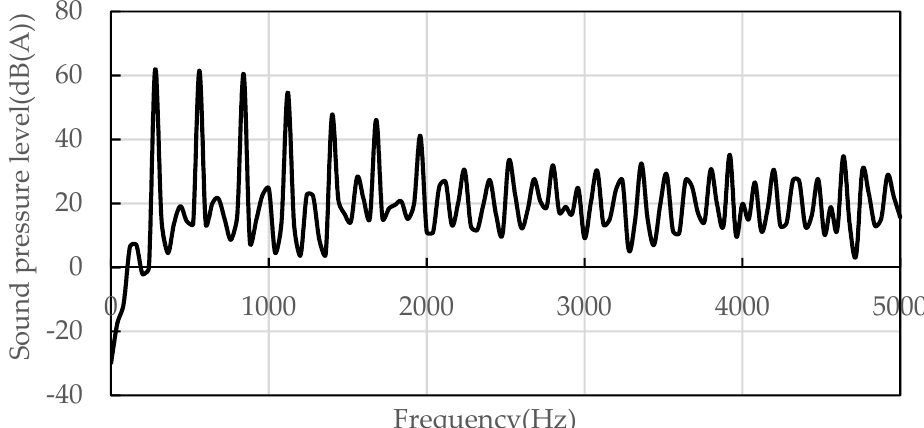
Figure 6. Calculation results of fan noise in the frequency domain.